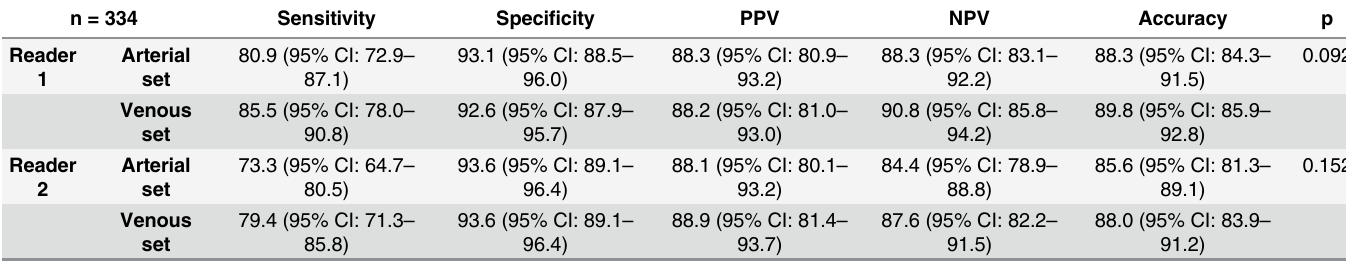
Table 2. Type 2 endoleak